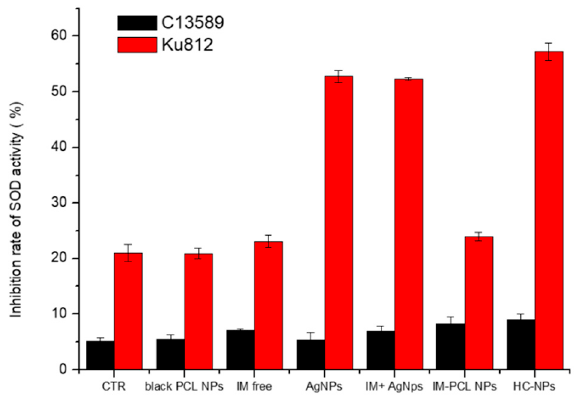
Figure 7. Inhibition rate of superoxide dismutase activity (SOD) in leukaemia KU812 and normal C13589 cell line after 6 h of treatment with black PCL NPs, free imatinib mesylate (IM), AgNPs, free IM / AgNP combination, IM-PCL NPs, and HC-NPs, compared with untreated control cells (CTR). Representative measurements of three independent experiments have been reported ( P < 0.05).